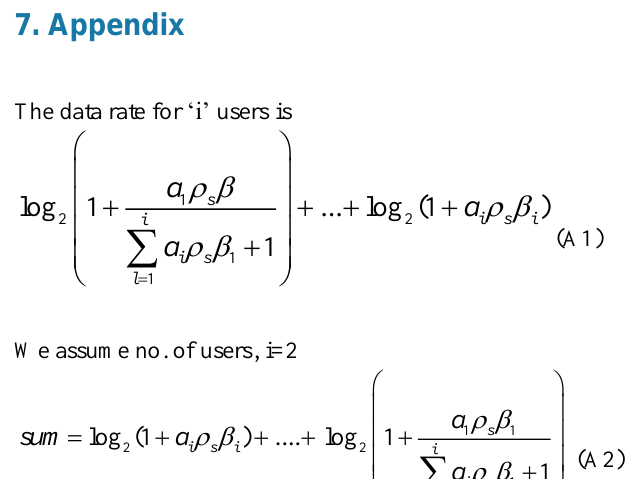
Figure 8. Power allocation Capacity vs. SNR (dB) of the proposed method in multi-user